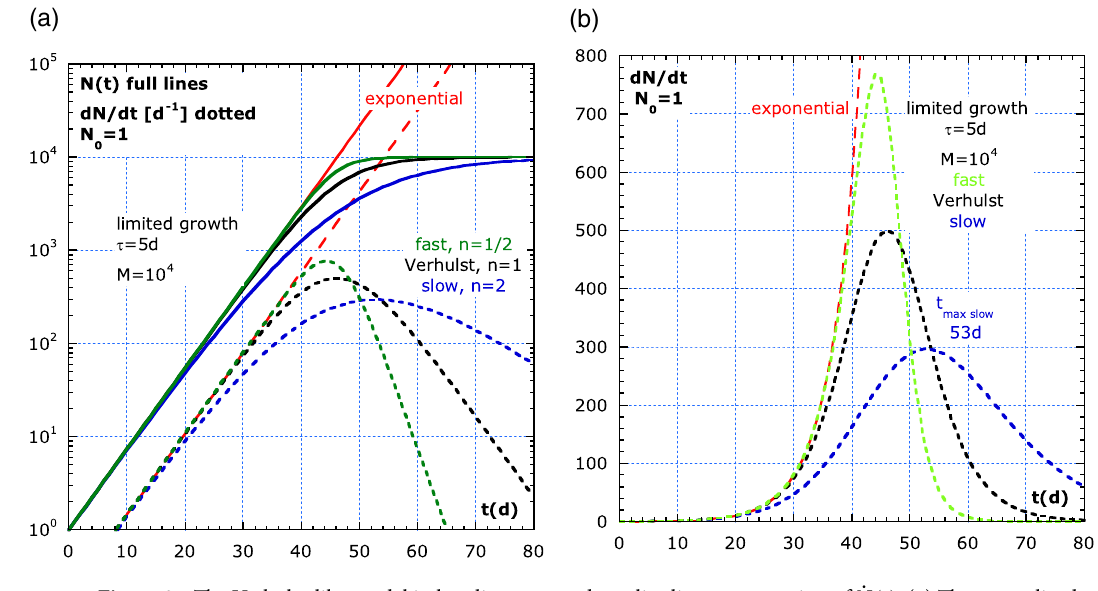
Figure 2. The Verhulst-like model in log–lin compared to a lin–lin representation of ˙ N ( t ) . ( a ) The generalized logistic model or Verhulst-like model: N ( t ) and ˙ N ( t ) are compared between fast (n = ½), medium (n = 1) and slow (n = 2) recovery. The Verhulst-like solution with M → ∞ is nothing else than the exponential. ( b ) lin–lin of N in ( a ). ˙